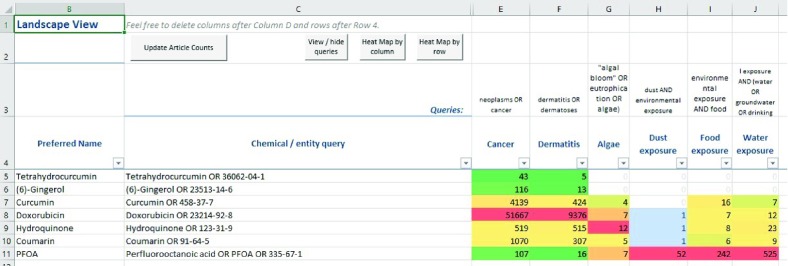
Landscape sheet.